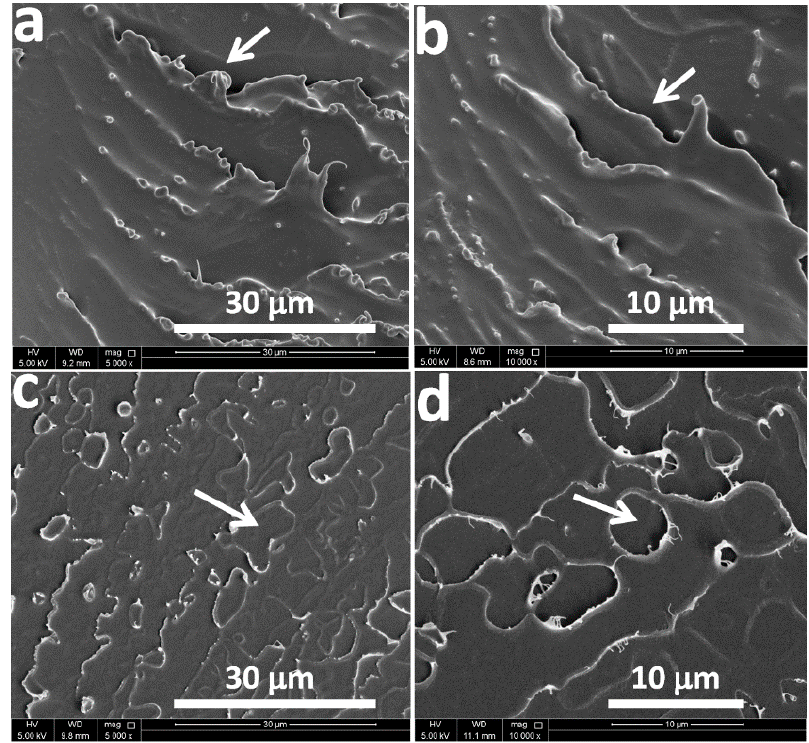
Figure 3. SEM photomicrographs of casted membranes by CF and THF at different amplifications. ( a , b ) refer to CF at bar scale 30 and 10 µm, and ( c , d ) refer to THF at bar scale 30 and 10 µm. The arrows refer to the morphology change.